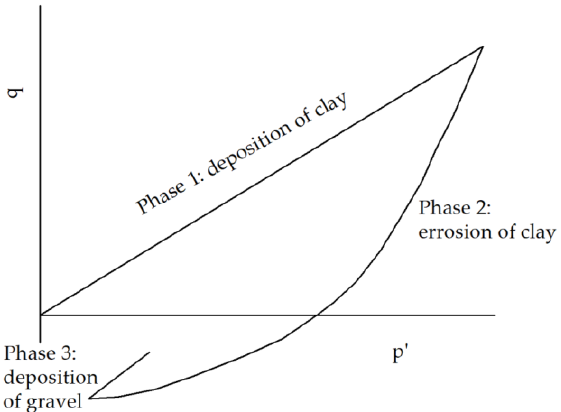
Figure 8. Schematic of the geological stress history of London clay (after [47]).